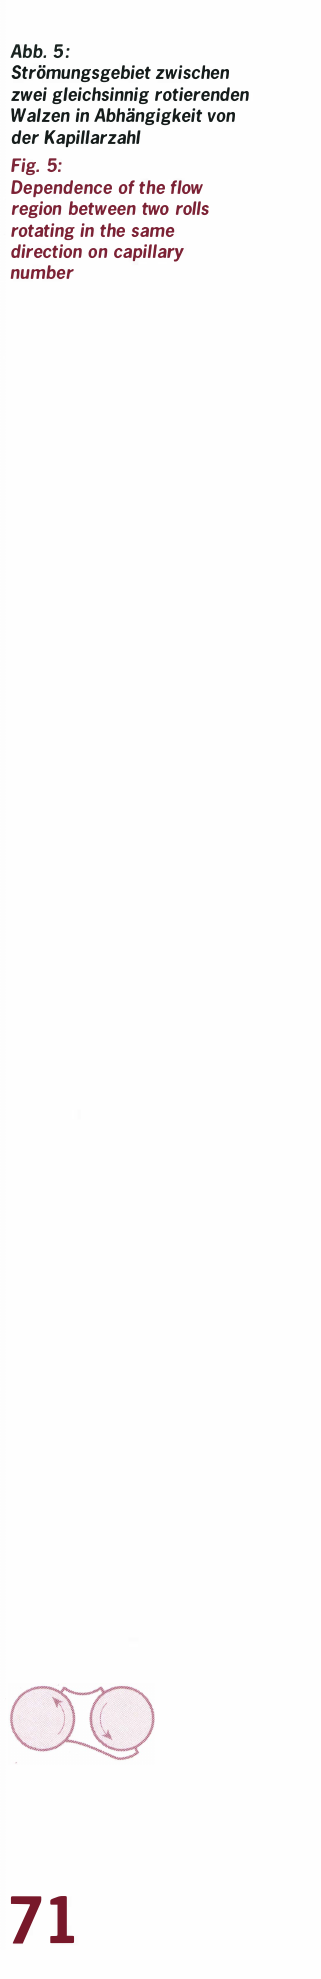
Abb. 5: Striimungsgebiet zwischen zwei g/eichsinnig rotierenden Walzen in Abhiingigkeit von der Kapil/arzah/ Fig. 5: Dependence of the flow region between two rolls rotating in the same direction on capillary